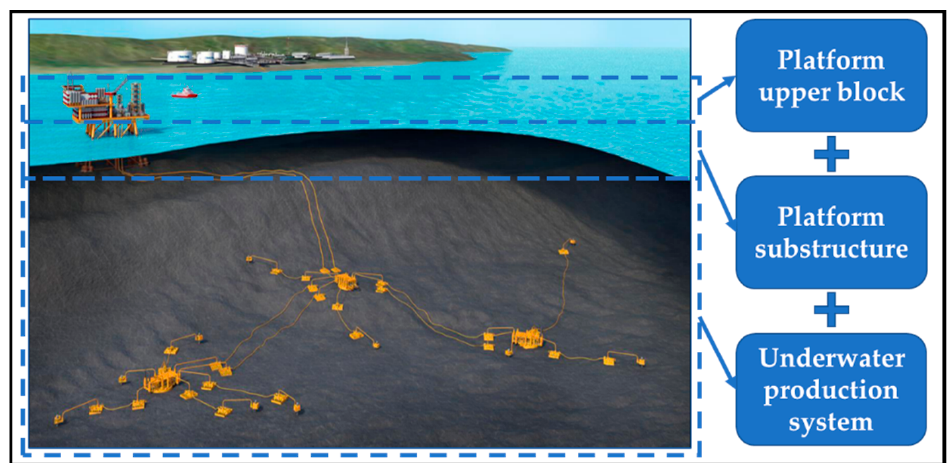
Figure 2. Investment composition of an offshore oil project.